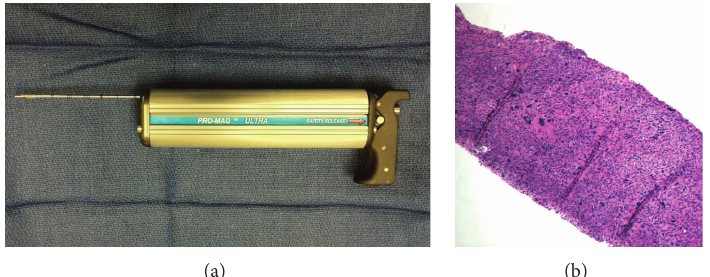
Figure 2: (a) Tru-Cut core needle biopsy device (Dyna Medical, Ontario, Canada). The device functions by discharging a spring-loaded hollow bored needle a distance of 2 cm into the targeted tissue to obtain the core specimen